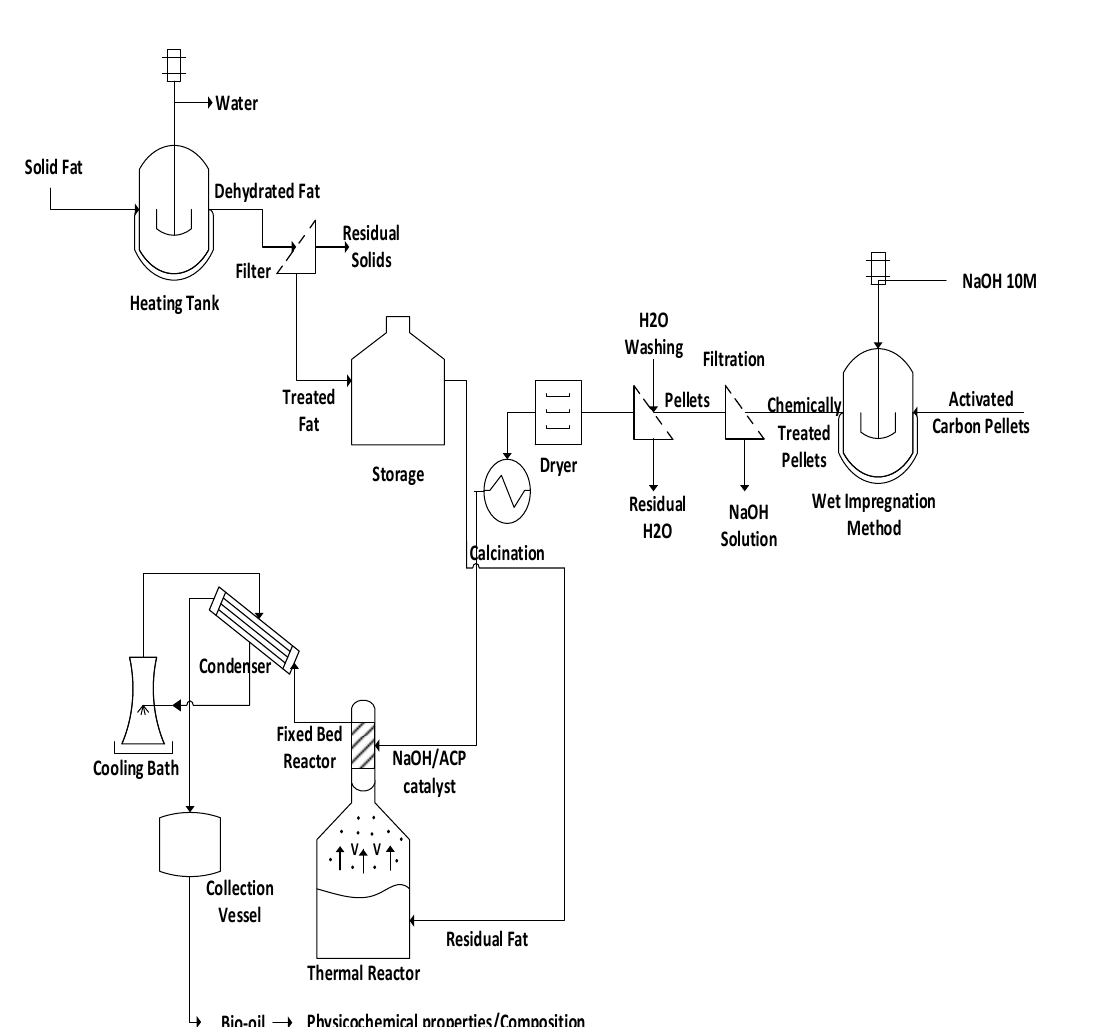
Figure 1. Process flowsheet by catalytic upgrading of residual fat vapors at 400 °C, 1.0 atm, 0.0%, 5.0%, 7.5%, and 10.0% (wt.) of activated carbon pellets impregnated with 10.0 M NaOH, using a catalyst fixed-bed reactor, in semi-pilot scale.